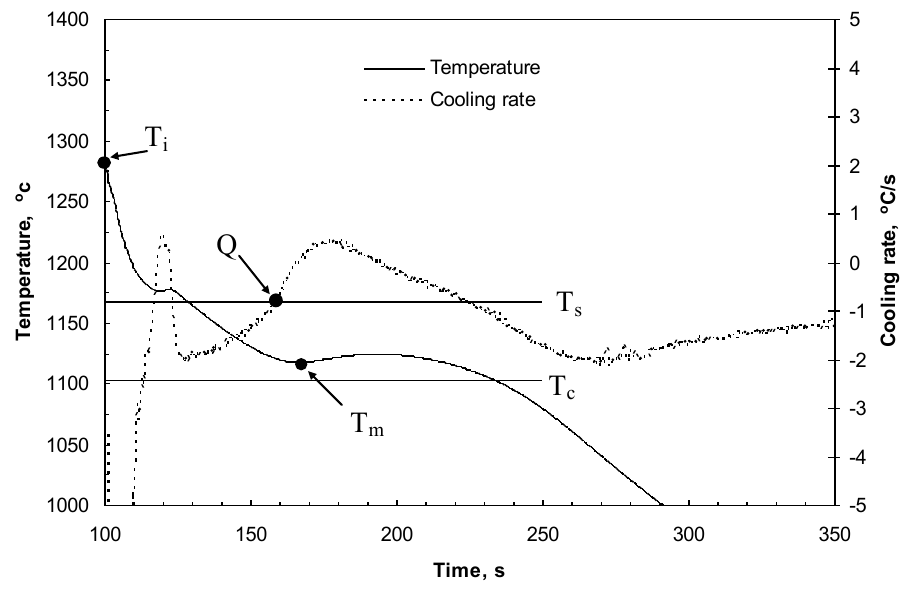
Figure 1. Cooling curves and cooling rate curves for cast iron. T i = initial temperature of the metal in the mold cavity just after pouring; T s = graphite eutectic equilibrium temperature; T c = cementite equilibrium temperature; T m = minimal temperature; and Q = cooling rate of cast iron at the onset of graphite eutectic